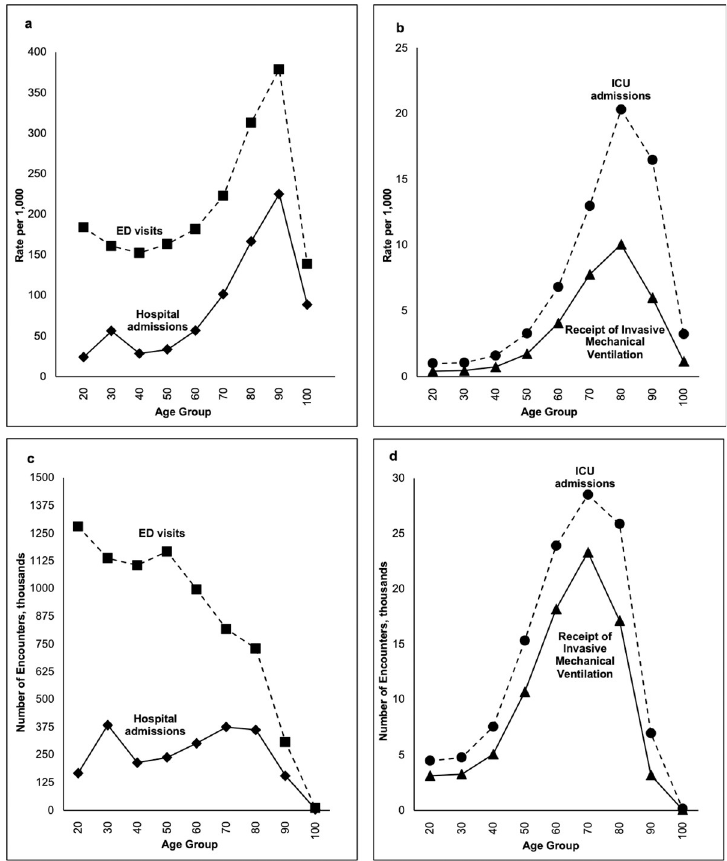
Fig 1. Age stratified trends in overall rates of: a) acute healthcare encounters; and b) critical care encounters, and overall volume of: c) acute healthcare encounters; and d) critical care encounters.